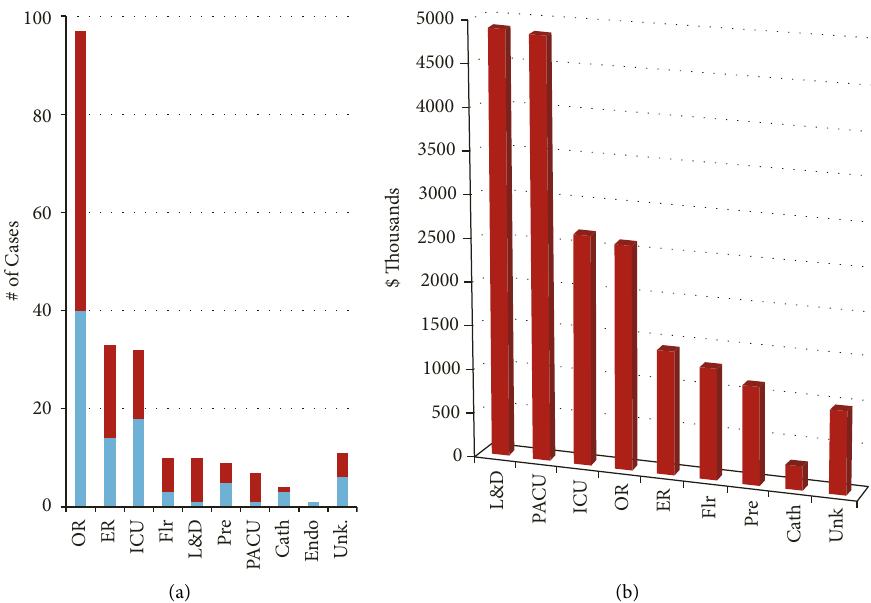
Figure 3: Physician defendant specialty. Anes � anesthesiology, ER � emergency medicine, surg � general surgery, OB � obstetrics and gynecology, pulm � pulmonology, ICU � intensive care unit (unspecified), ENT � otolaryngology, peds � pediatrics, FM � family medicine, cards � cardiology.